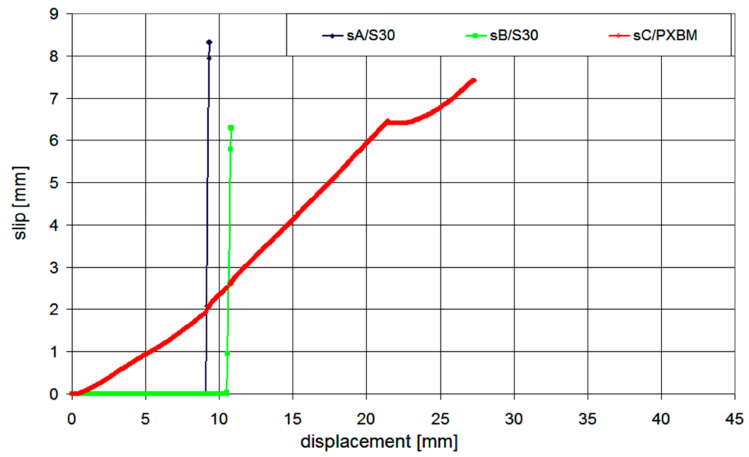
Figure 11. The laminate end slips, measured at the points sA, sB, and